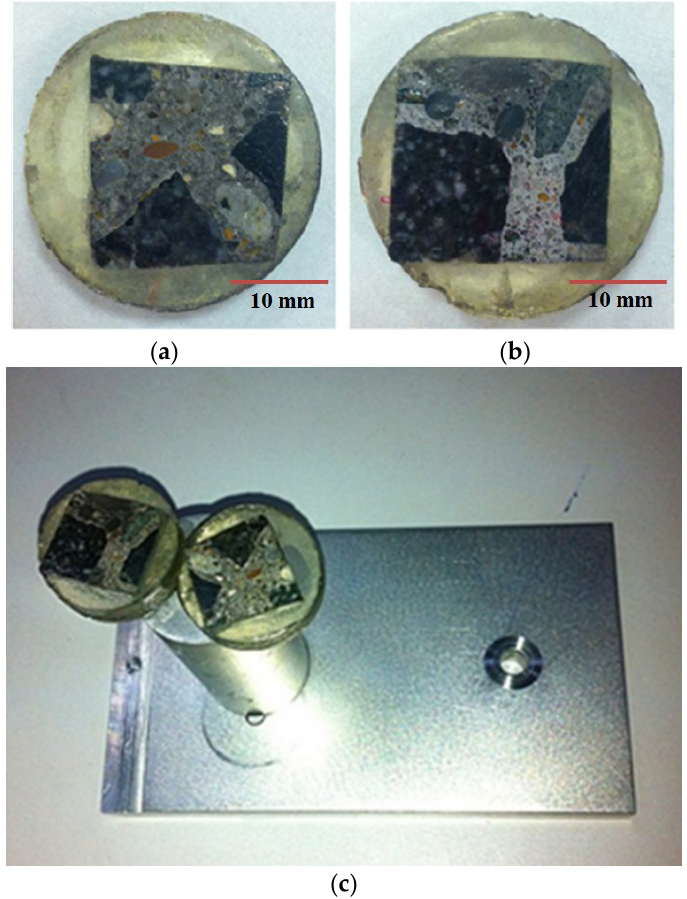
Figure 1. Samples for testing in nanoindenter: ( a ) specimen 1; ( b ) specimen 2; and ( c ) specimens Figure1. Samplesfortestinginnanoindenter: ( a )specimen1; ( b )specimen2; and( c installed.